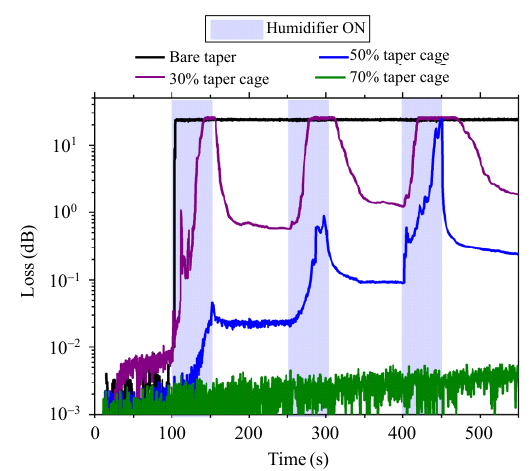
Fig. 4 Time evolution of the optical loss of tapered fibers (1 μ m diameter) embedded in 3D printed cages with 30% (purple curve), 50% (blue curve), and 70% (green curve) material filling densities. Data for the bare fiber taper are shown in